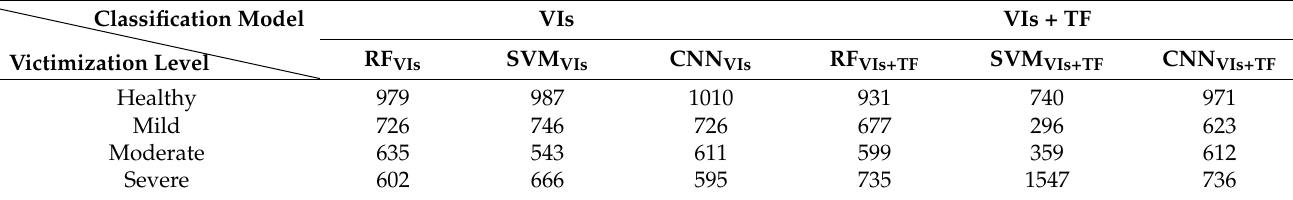
Table 4. Results of identifying the degree of EJD damage to forest trees. Unit: